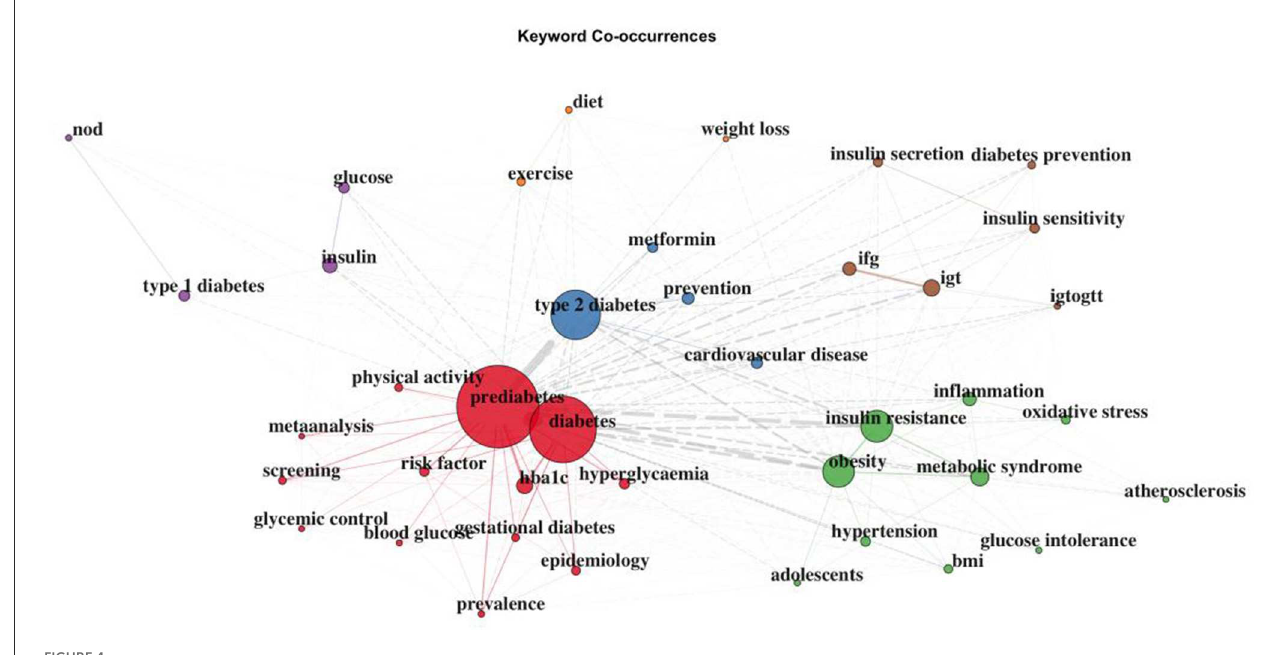
FIGURE4 Co-occurrence network of the top 400 keywords.